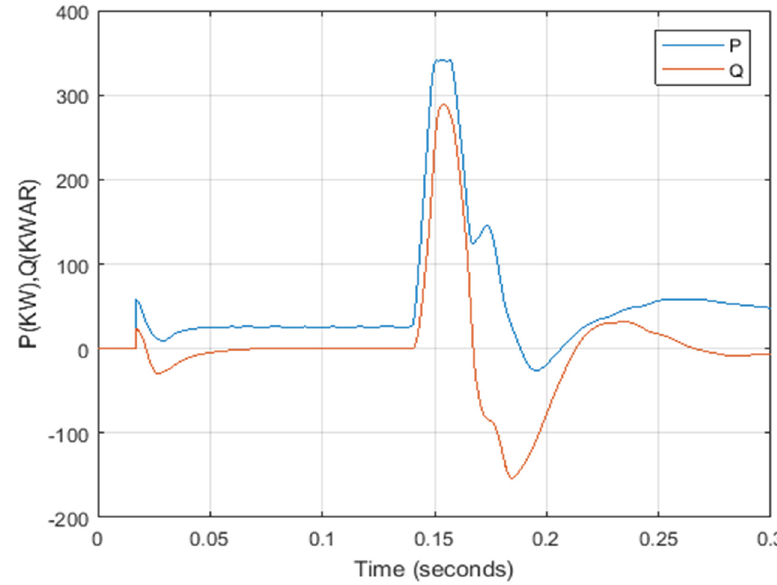
Figure 15. Active and reactive power distribution.